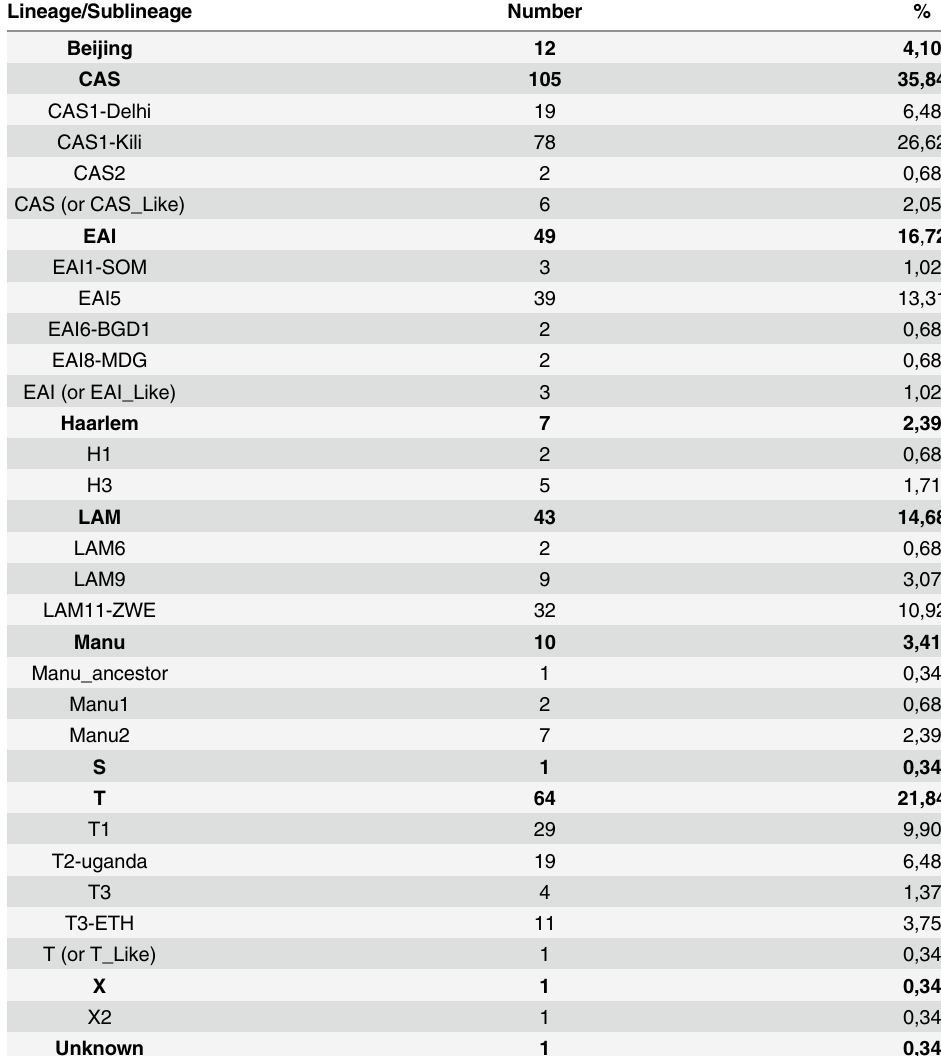
Table 1. Distribution of lineages/sublineages of isolates from Tanzania (n = 293).